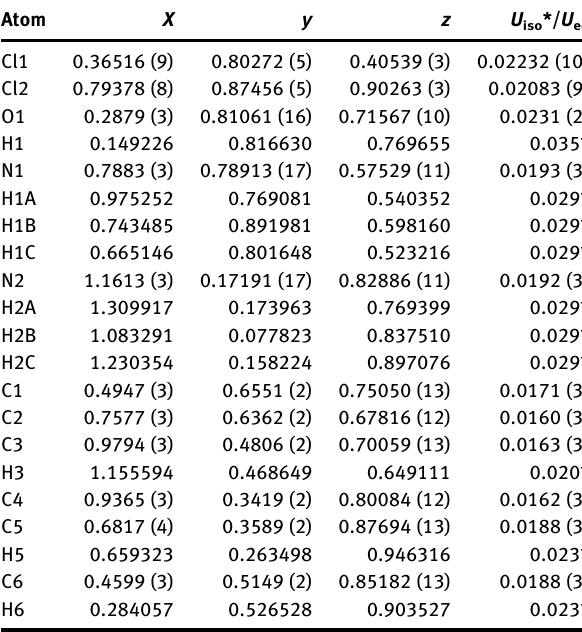
Table  : Fractional atomic coordinates and isotropic or equivalent isotropic displacement parameters (Å 